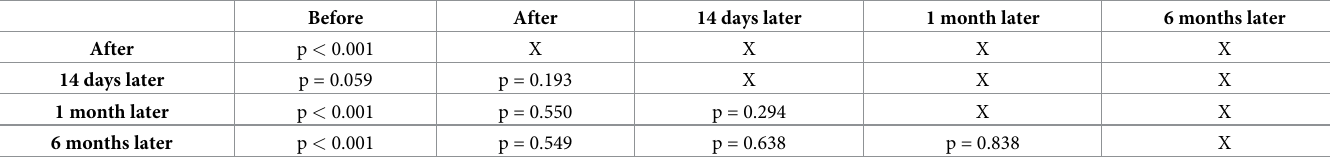
Table 2. The results of testing the levels of knowledge of students who participated in school education in time.